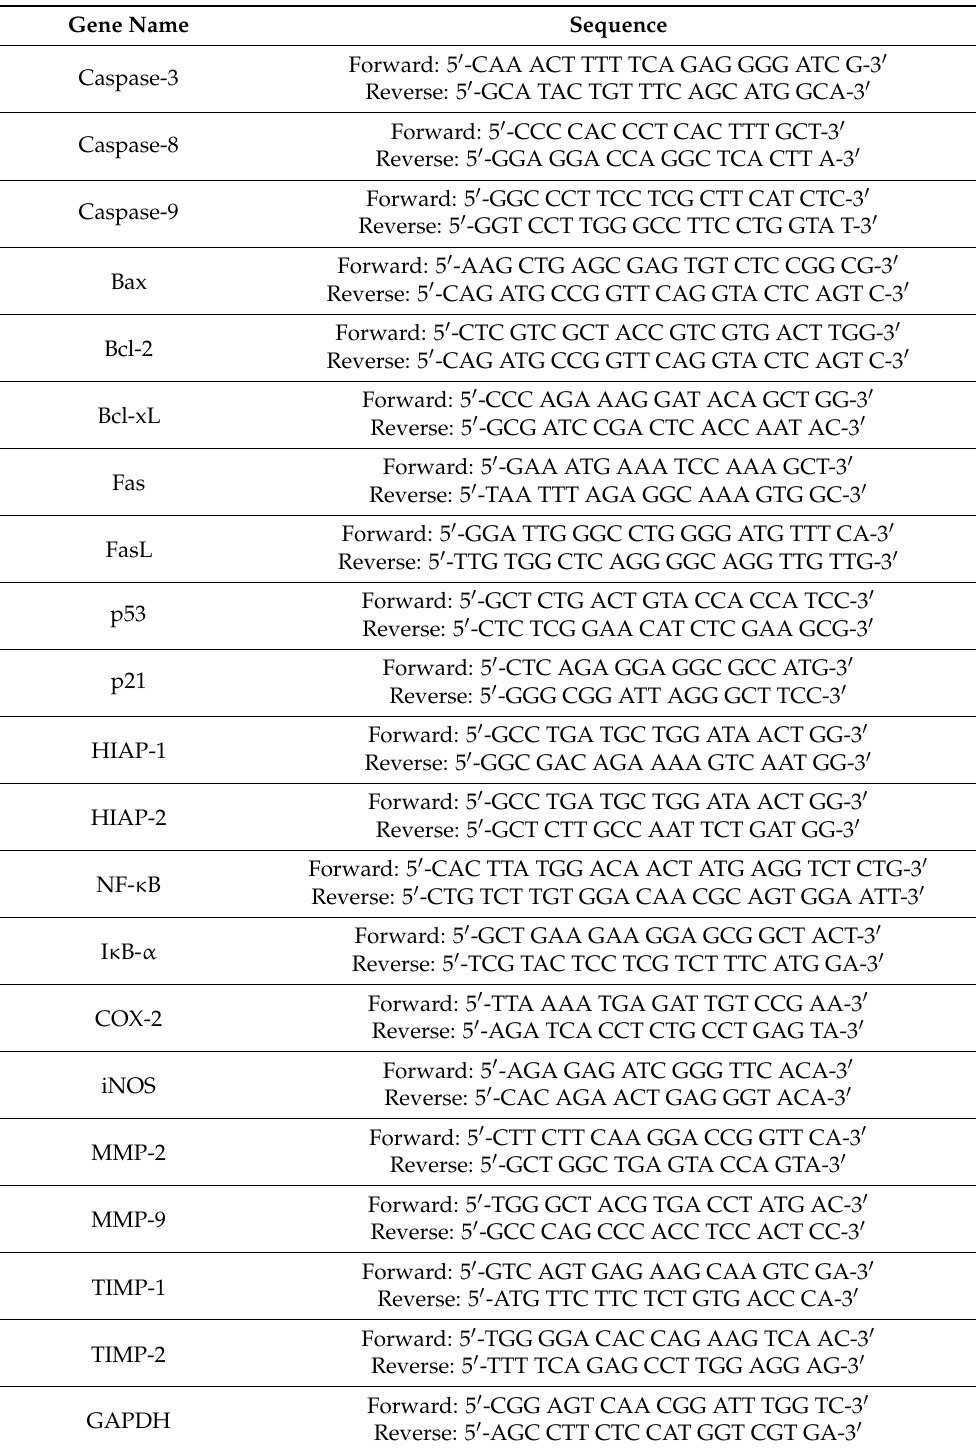
Table 2. Sequences of primers were used in this